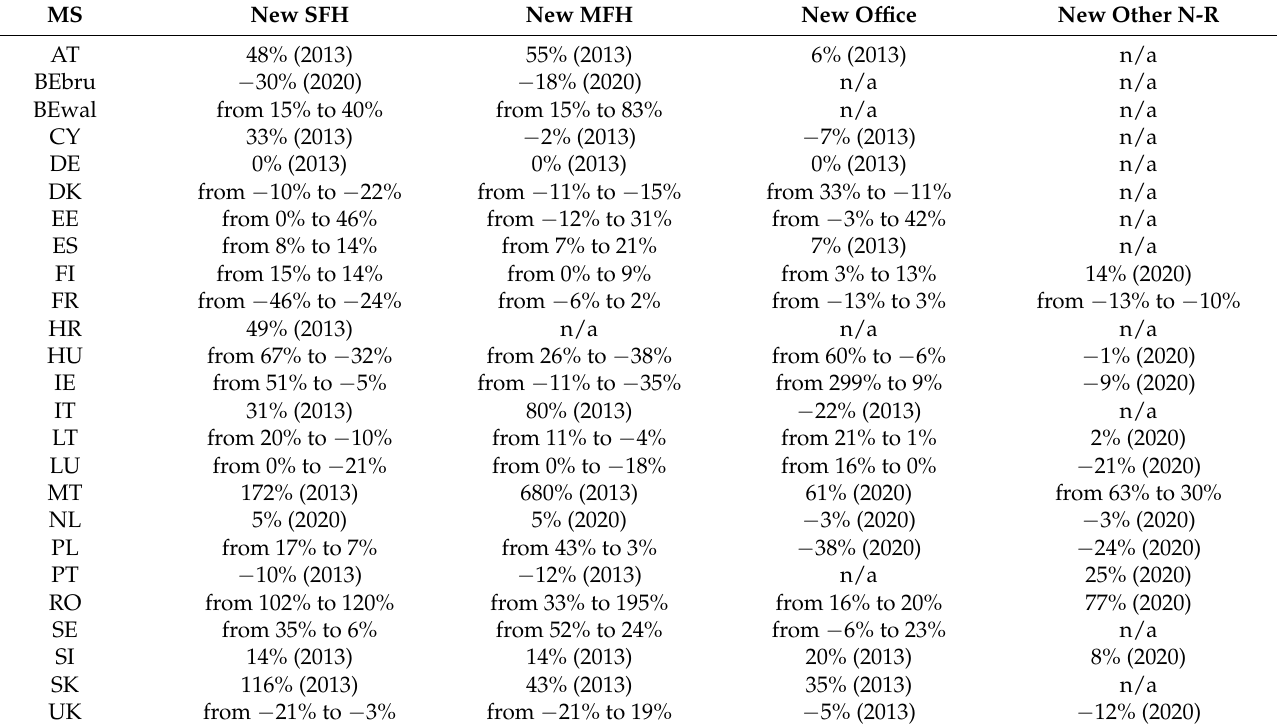
Table 8. Consolidated version of shortfalls against minimum energy performance requirements for new buildings, with comparisons between the 2013 and 2020 values when available. A negative gap means that the requirement is lower than the cost-optimal